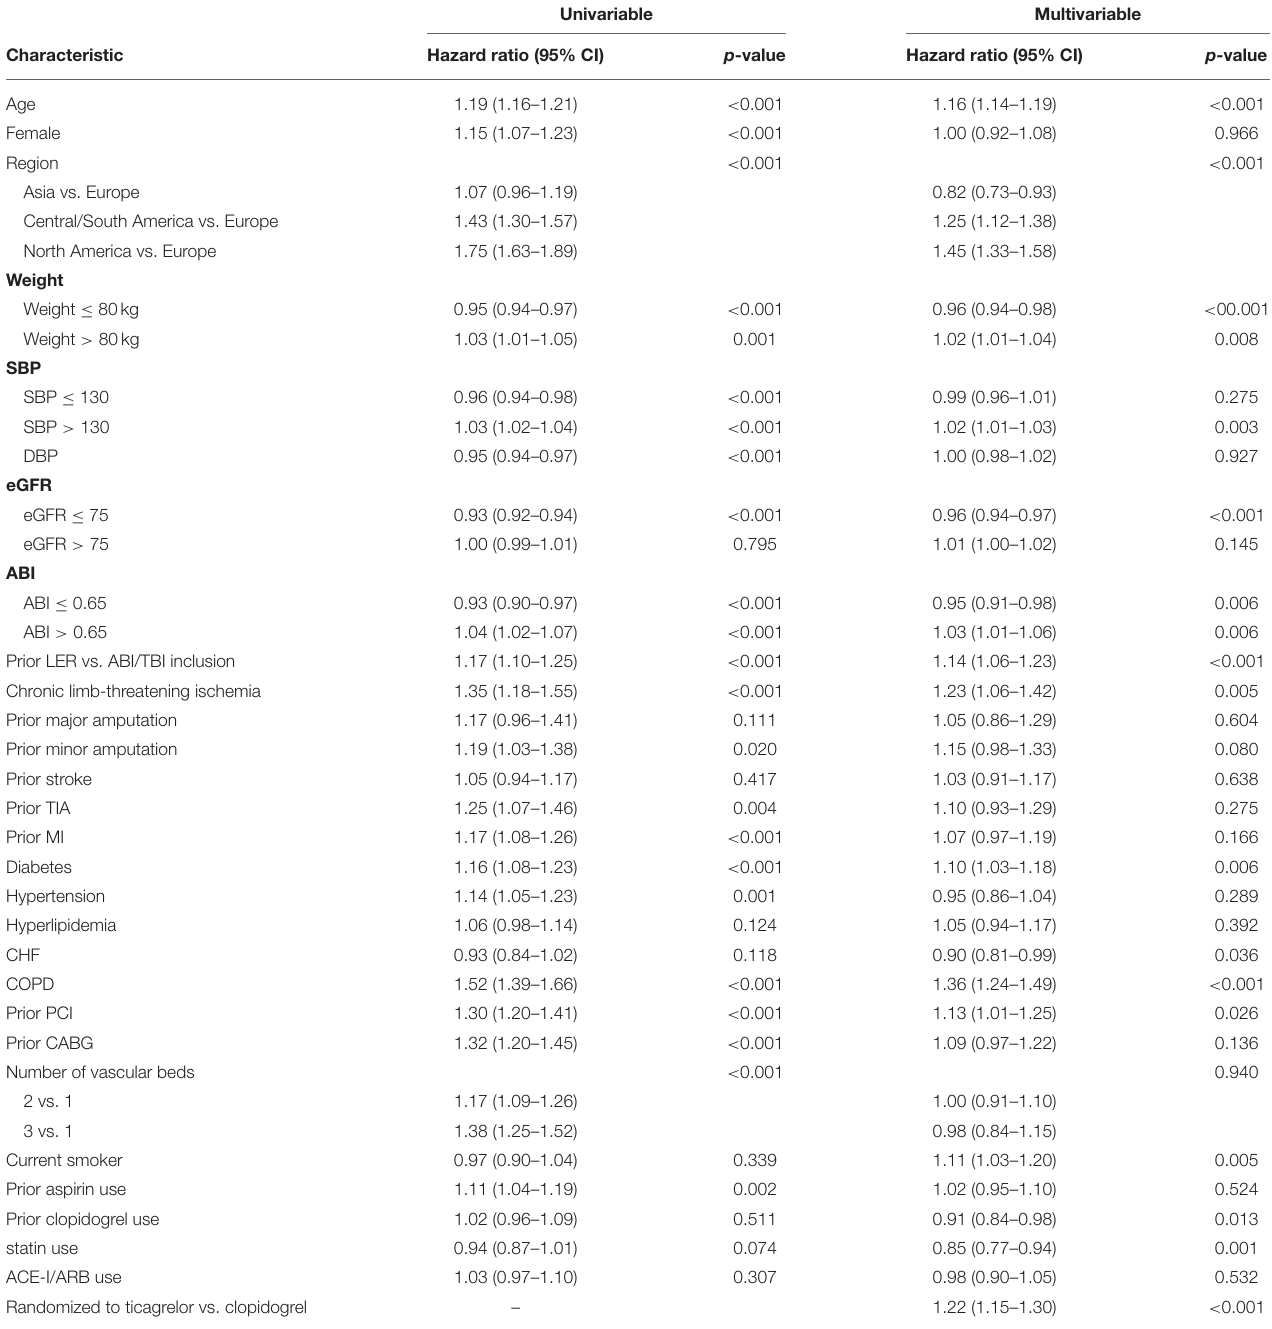
TABLE 3 | Factors associated with premature, permanent study drug discontinuation in EUCLID.